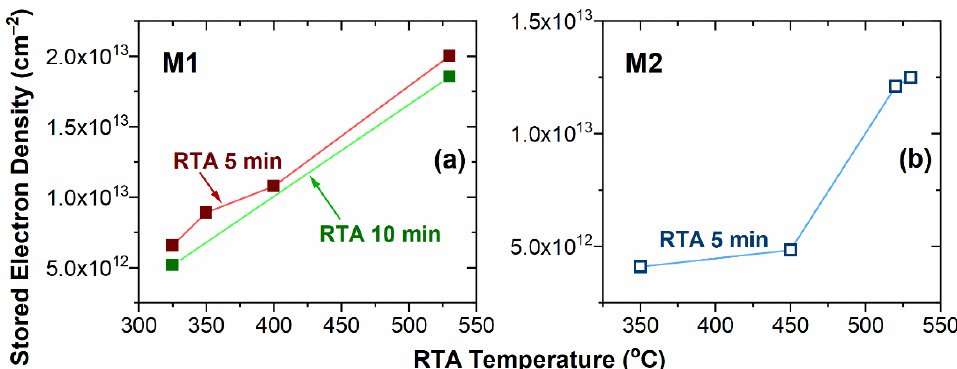
Figure 6. Stored electron density n in function of RTA temperature in structures: ( a ) M1 and ( b ) M2. The stored electron density was evaluated by using the relation ∆ V × ( d ε g / κ g + d NC, FG /2 κ NC, FG ) [22,31,32] considering the structure and fb = ( q n / 0 )